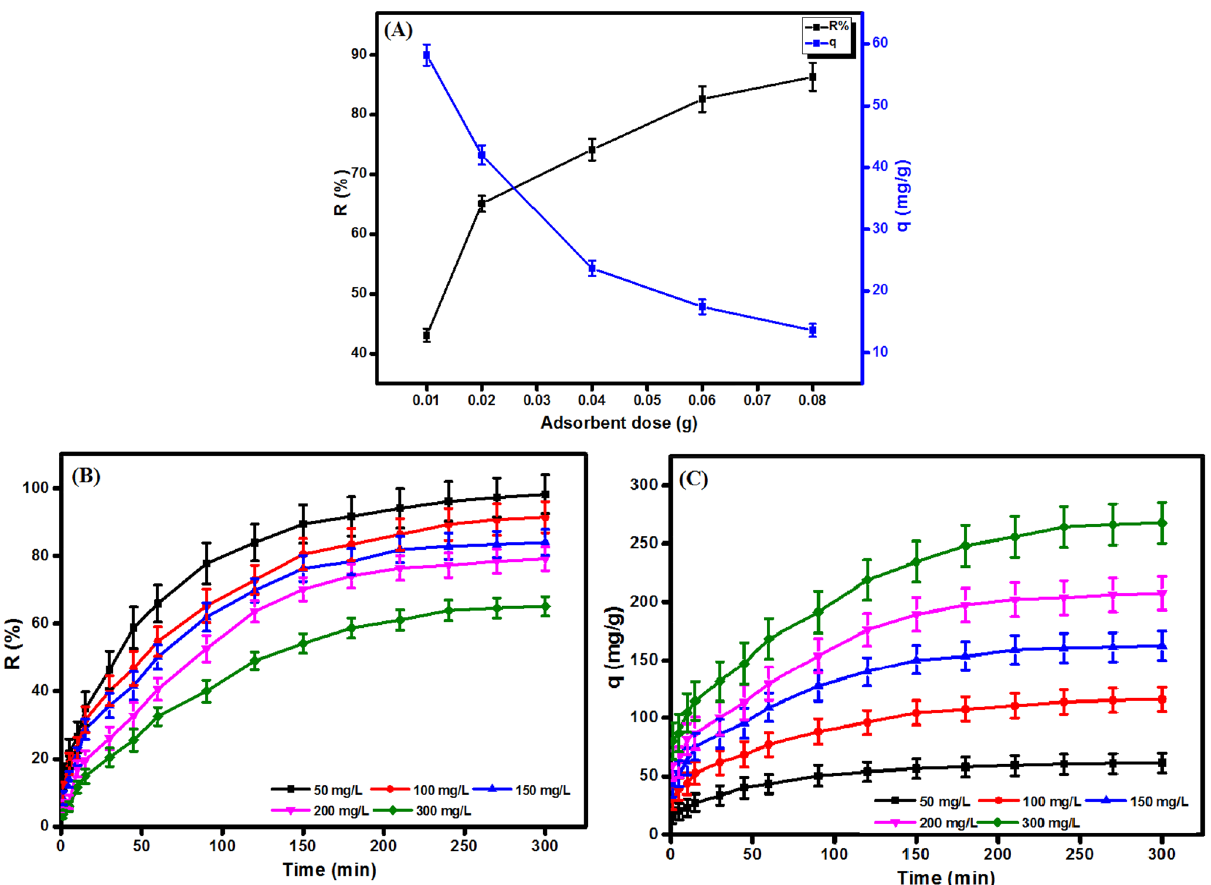
Figure 8. ( A ) Effect of adsorbent dose, ( B , C ) effect of initial concentration of the removal efficiency and adsorption capacity of TC onto MIL-125(Ti)/MIL-53(Fe)/CNT@Alg composite